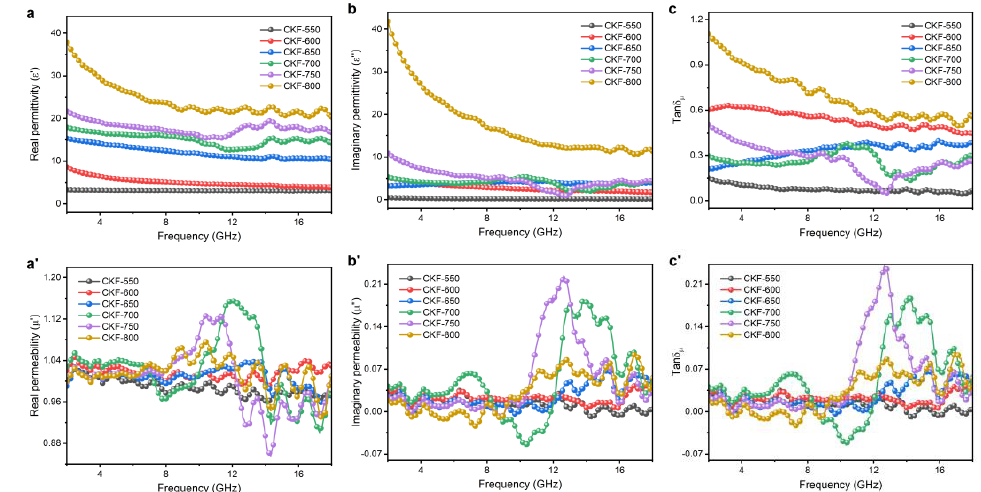
Figure 6. Frequency-dependent electromagnetic parameters for CKF: ( a ) real part ( ε ′) and ( b ) imag- inary part ( ε ′′) of complex permittivity, ( c ) dielectric loss (tan δ ε ), ( a′ ) the real part ( μ ′) and ( b′ ) im- aginary part ( μ ′′) of complex permeability, and ( c′ ) ma gnetic loss (tan δ μ ).